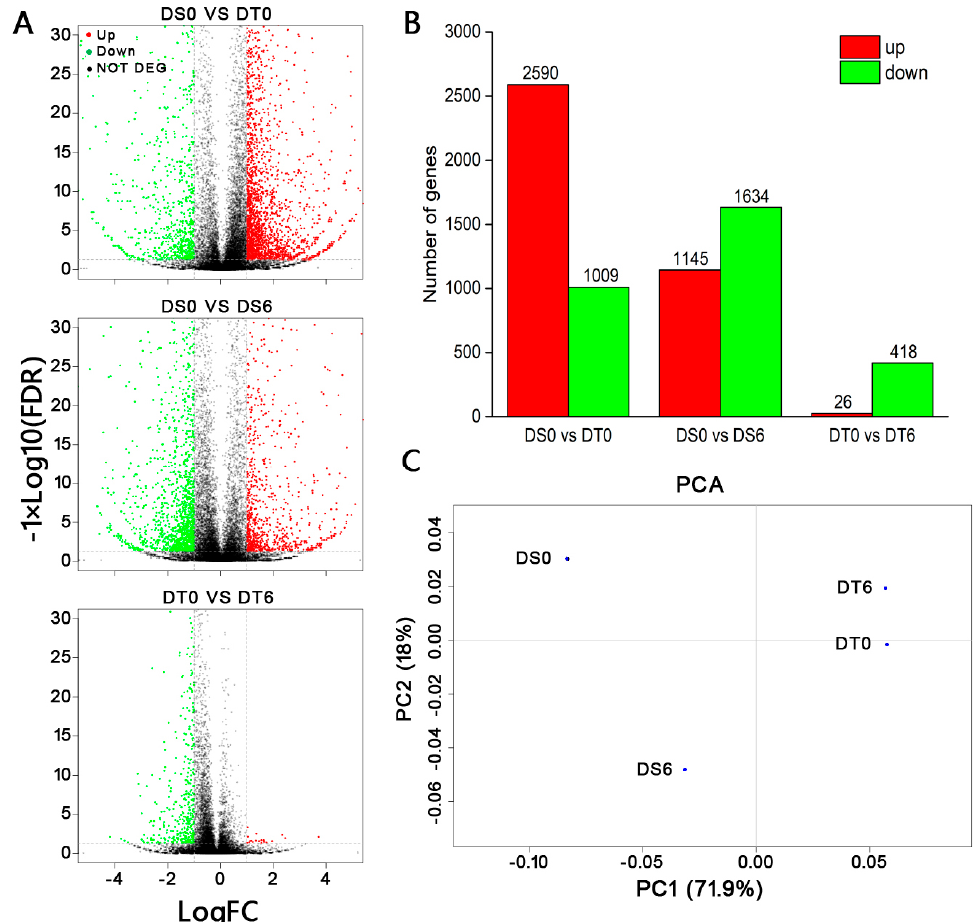
Figure 4. Differentially expressed genes (DEGs: FDR < 0.05 and absolute log 2 fold change ≥ 1) were identified for three different comparisons. ( A ) Volcano plots depicting DEGs between two seed lots before desiccation (DS0 vs. DT0) and within seed lots exposed to desiccation (DS0 vs. DS6, DT0 vs. DT6). Red dots indicate significantly up-regulated genes, green dots indicate significantly down-regulated genes, and black dots represent non-DEGs. ( B ) Up-(red) and down-regulated (green) DEGs for each comparison. ( C ) Principal component analysis for the four molecular analysis: DS0, desiccation sensitive seeds dried for 0 d, DS6, desiccation sensitive seeds dehydrated for 6 d, DT0, desiccation tolerant seeds dried for 0 d and DT6, desiccation tolerant seeds dehydrated for 6 d.